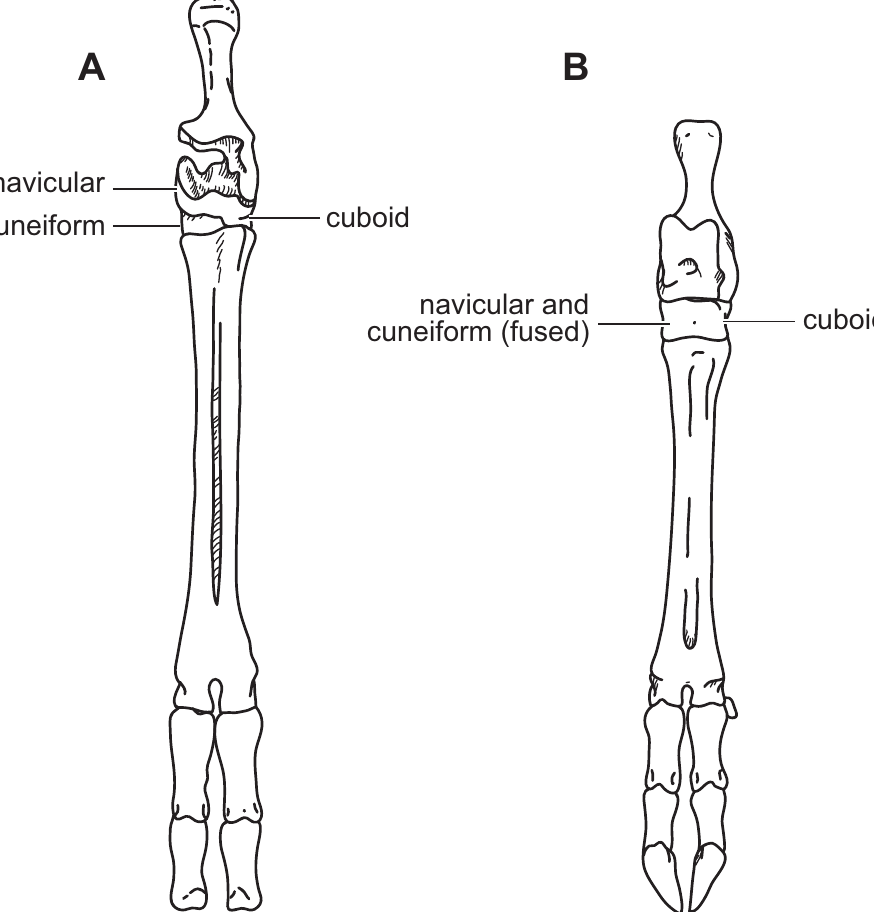
Figure 3. Hind foot bones of Mazama rufina ( A ) and Pudu puda ( B ) sensu Hershkovitz (1982). Accord- ing to Hershkovitz (1982; see also Brooke 1874, 1878), the union of the cuboideonavicular and external and middle cuneiform tarsal bones into a single bone in Pudu is the only osteological characteristic shared by P. puda and P. mephistophiles that consistently separates them from all other living deer, with exception of the genera Elaphodus and Muntiacus